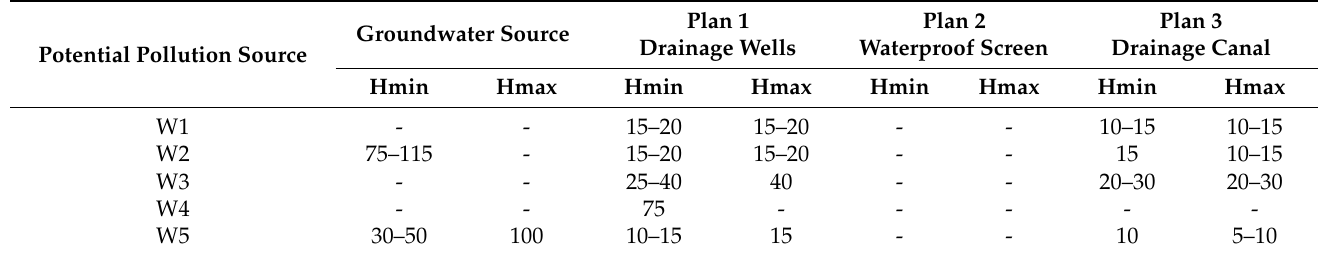
Table 2. Travel time of conservative particle from industrial wells to source protection systems.